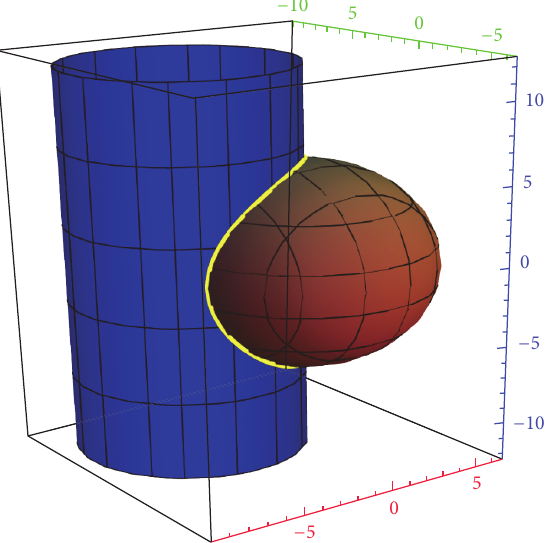
Figure 5: The fiber F (ℎ,𝑐) , (ℎ,𝑐) ∈ Σ 𝑝 2 : a periodic orbit.